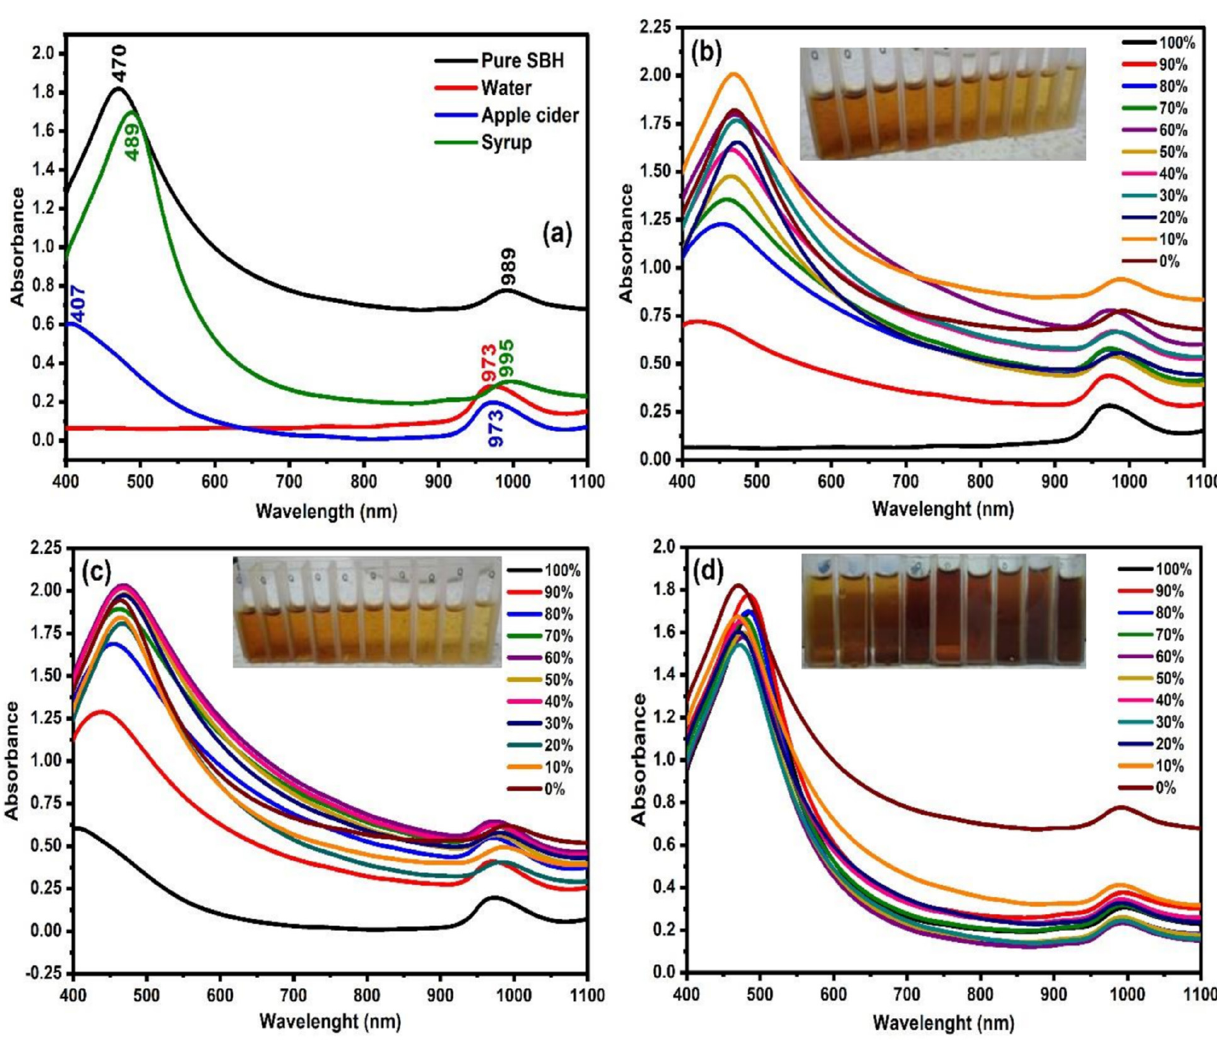
Figure 2. Vis-NIR spectra of ( a ) Pure SBH and adulterants and adulterated SBH by different per- centages of water ( b ), apple cider ( c ), and fructose syrup ( d ).